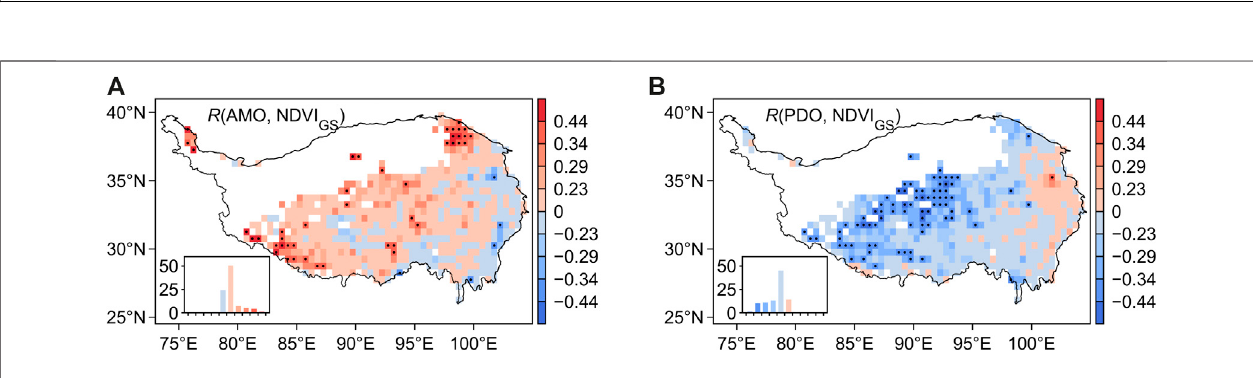
Frontiers in Environmental Science |